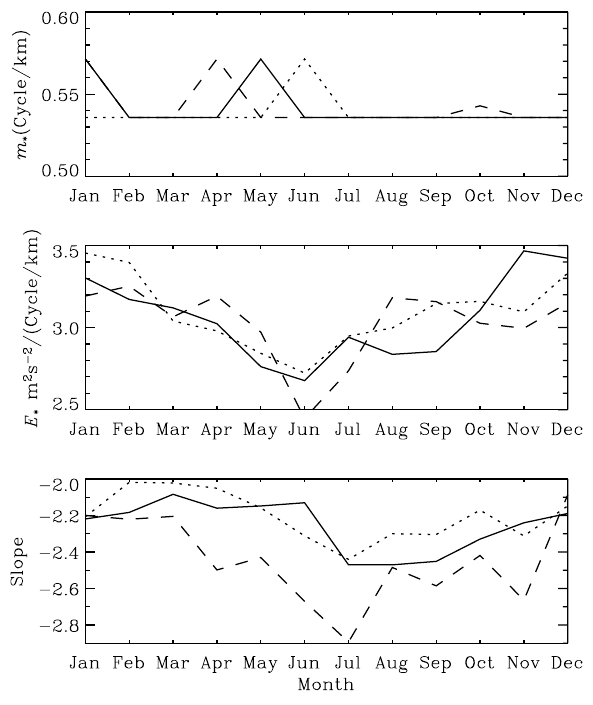
Fig. 6. Similar to Fig. 5, but for the monthly variations of the spec- tral parameters of the mean vertical wave number spectra for GWs in the lower